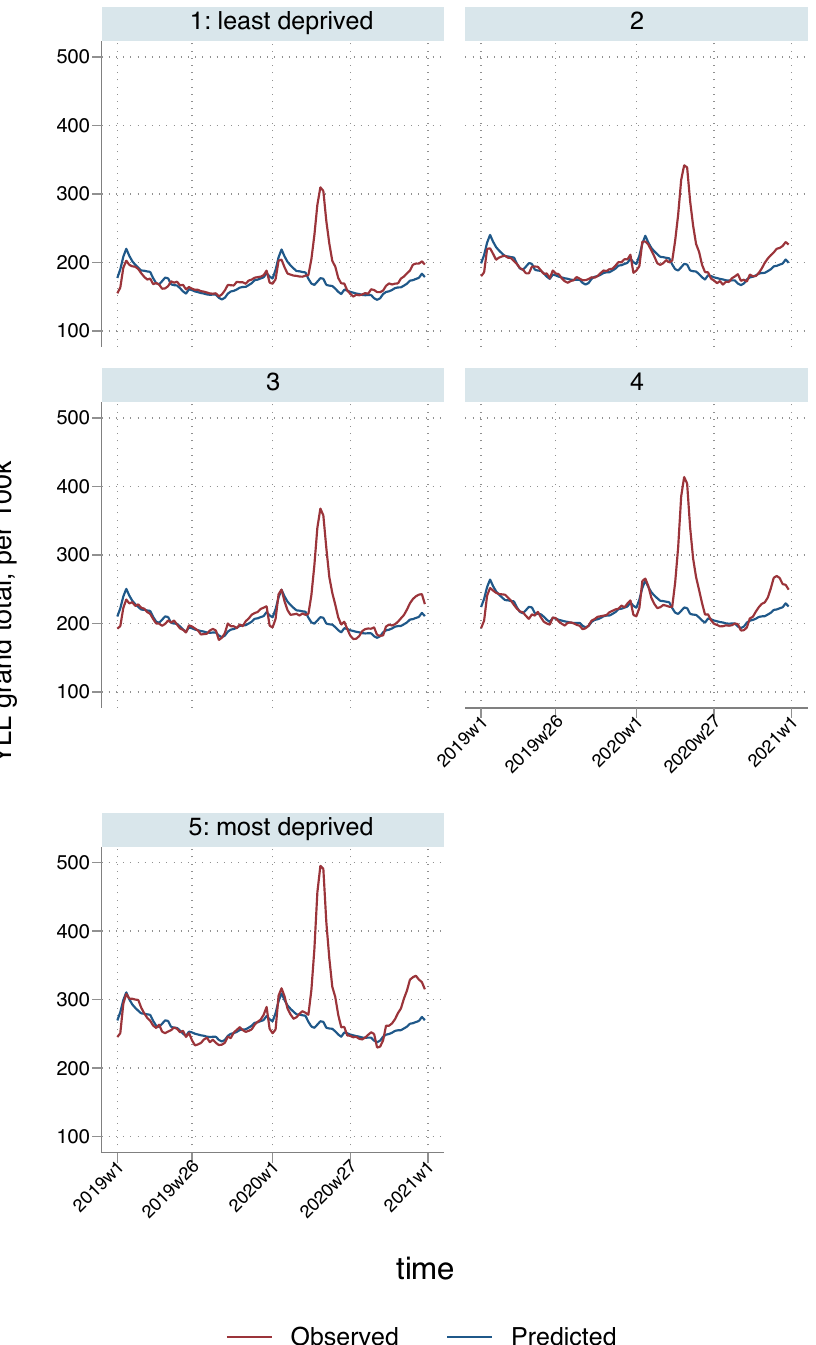
Fig 2. Temporal patterns in YLL per 100,000 population due to all-cause deaths, by deprivation quintile � . � 3-week smoothed. YLL, years of life lost.